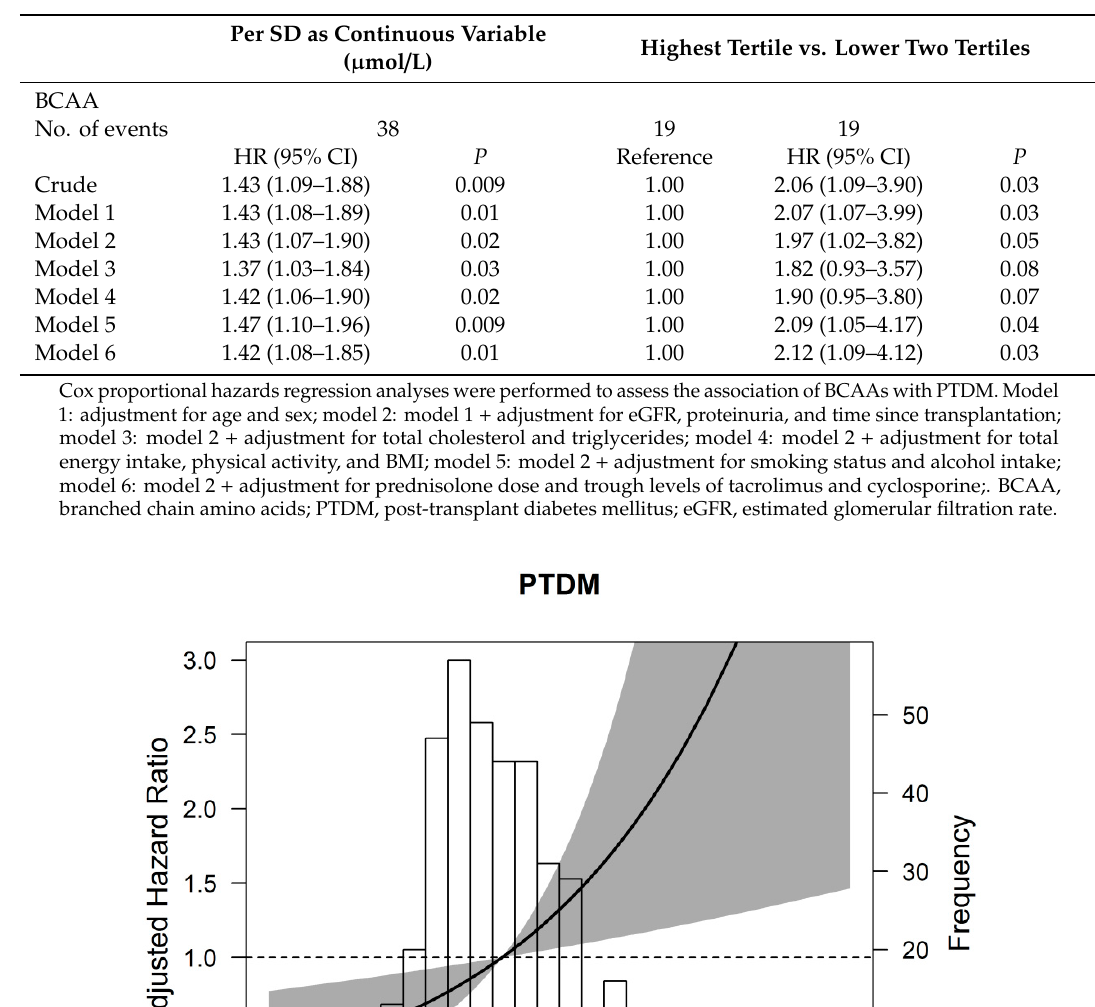
Table 3. Association of plasma BCAAs with post-transplant diabetes mellitus in renal transplant recipients ( n = 386).